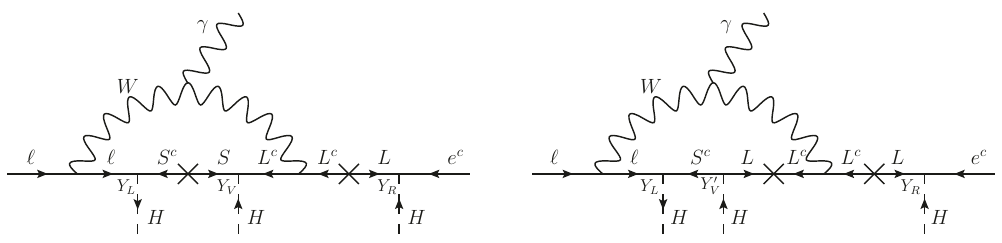
Figure 4 . Diagrams that generate dimension-eight ( g − 2) µ operators in the full UV